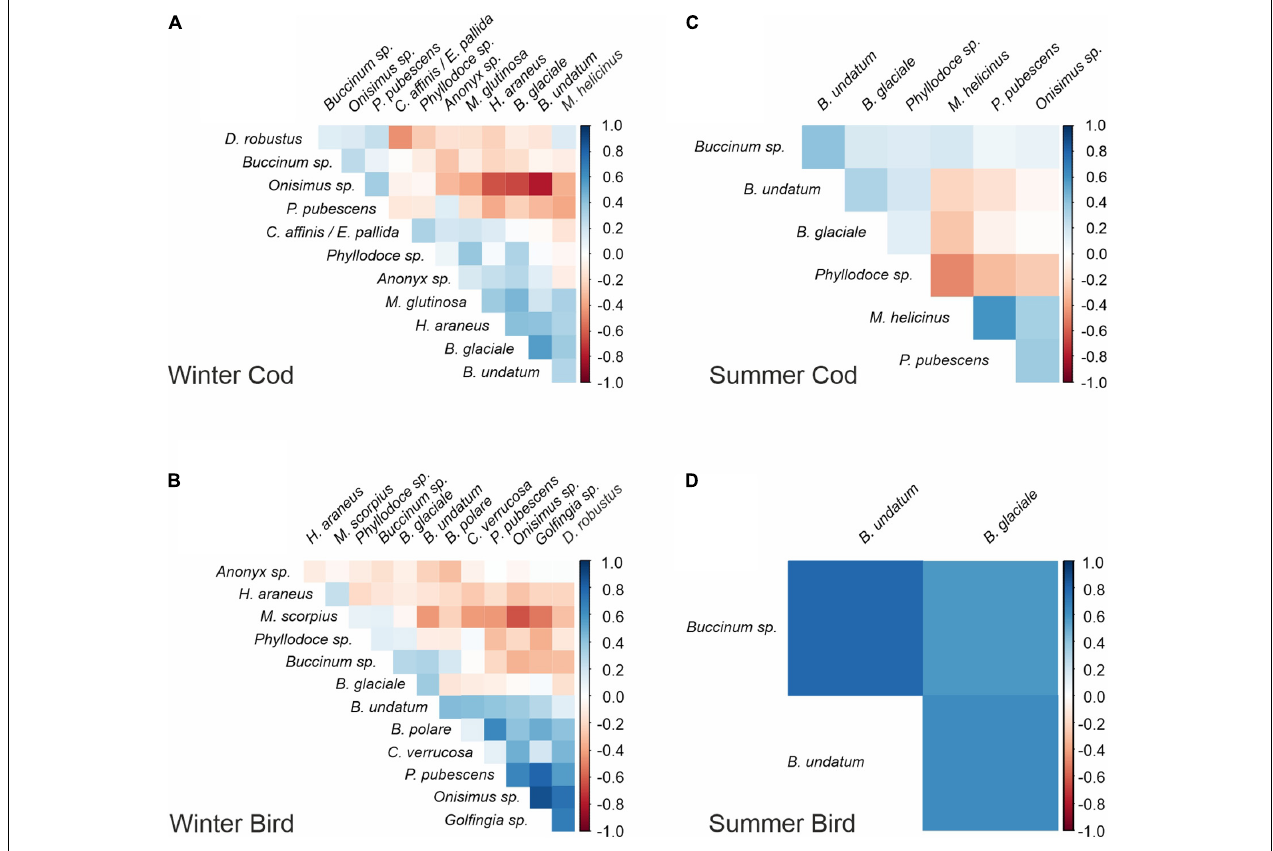
FIGURE 9 | (A–D) Correlations among pairs of species estimated using copulas for different bait types (cod, bird) and seasons (winter,